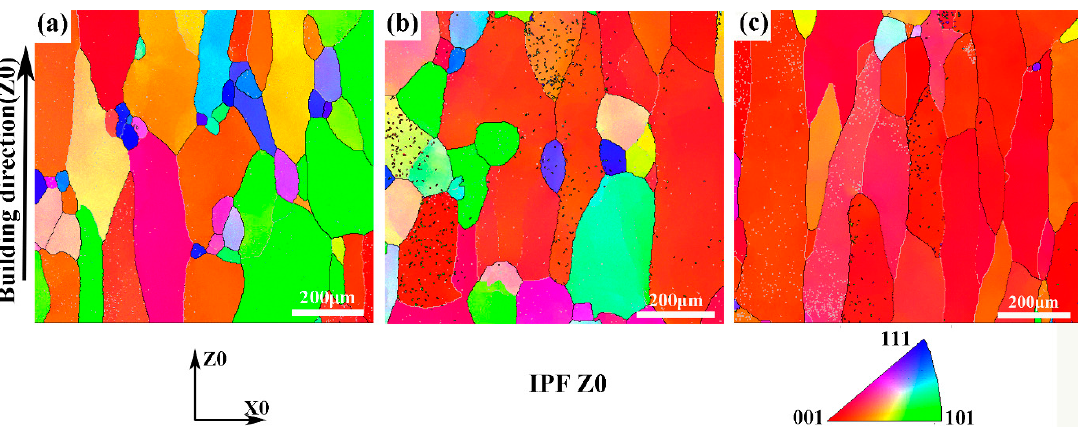
Figure 9. IPFZ electron backscatter diffraction (EBSD) map presented with respect to z-direction showing multiple grain orientations: ( a ) as-deposited Ti–26Nb alloy; ( b ) after annealing at 650 °C; ( c ) after annealing at 850 °C.